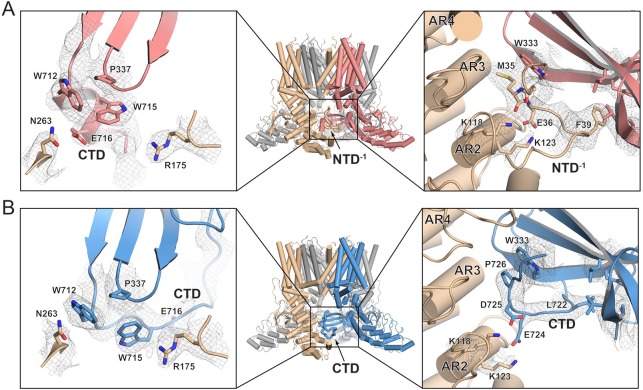
Cryo-EM map density around the CTD and NTD of TRPV2APO_1 and TRPV2CBD_2.Model representation of the distal CTDs of (A) left panel) TRPV2APO_1 (salmon) and (B) left panel) TRPV2CBD_2 (blue). This view is of the back of the region indicated by the black square on the overall models (A–B) center panels). Model representation of the distal NTD of (A) right panel) TRPV2APO_1 (salmon) and the distal CTD of (B) right panel) TRPV2CBD_2 (blue). This view is of the front of the region indicated by the black square on the overall models (A–B) center panels). Chain A of each model is colored salmon (TRPV2APO_1) or blue (TRPV2CBD_2). For both models, the adjacent chain B is colored wheat. Residues of interest are represented as sticks. Cryo-EM map density is contoured to σ = 5.